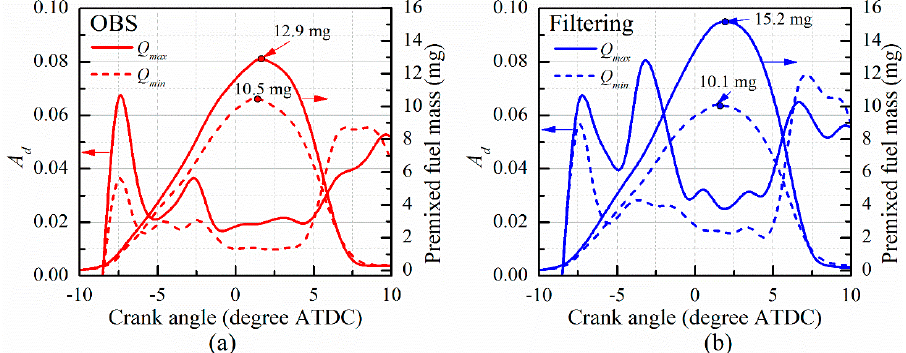
Figure 10. Comparison of the predicted evaporation index, A d (on the left Y axis), and premixed fuel mass (on the right Y axis) between Q max and Q min over 200 cycles for ( a ) the OBS method and ( b ) the filtering method. p t = 150 MPa, Q t = 44.05 mg. ATDC: After Top Dead